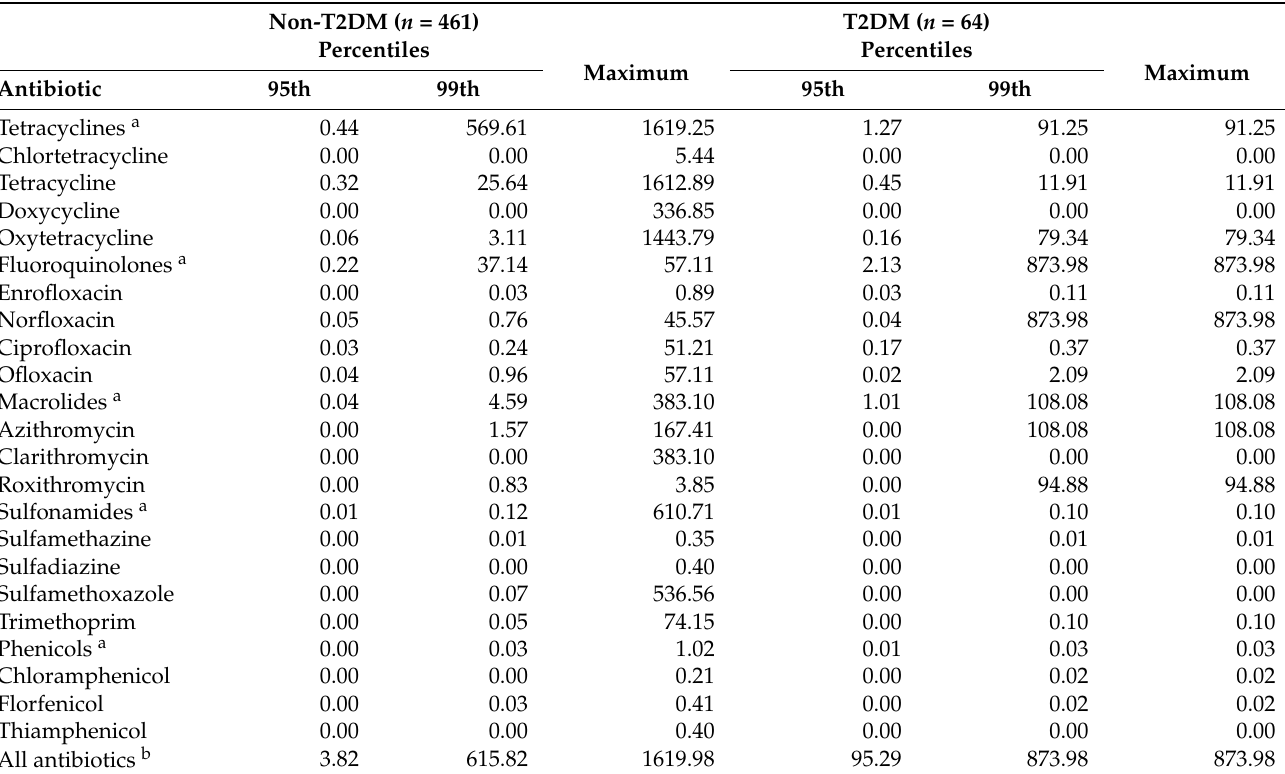
Table 2. Estimated daily intake of antibiotics ( µ g/kg/day), on the basis of urinary concentrations of antibiotics in middle-aged and older people in Xinjiang ( n =